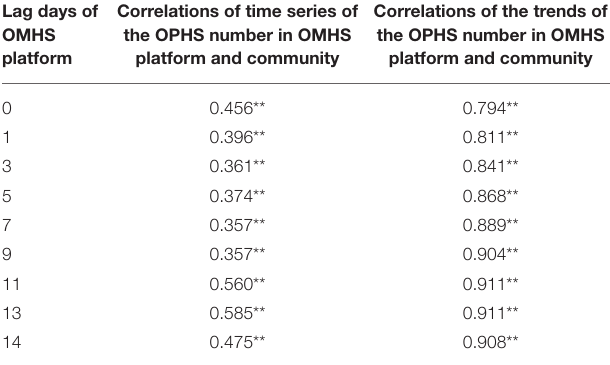
TABLE 1 | The correlations between the time series of the online psychological help-seeking (OPHS) number in the online mental health service (OMHS) community and